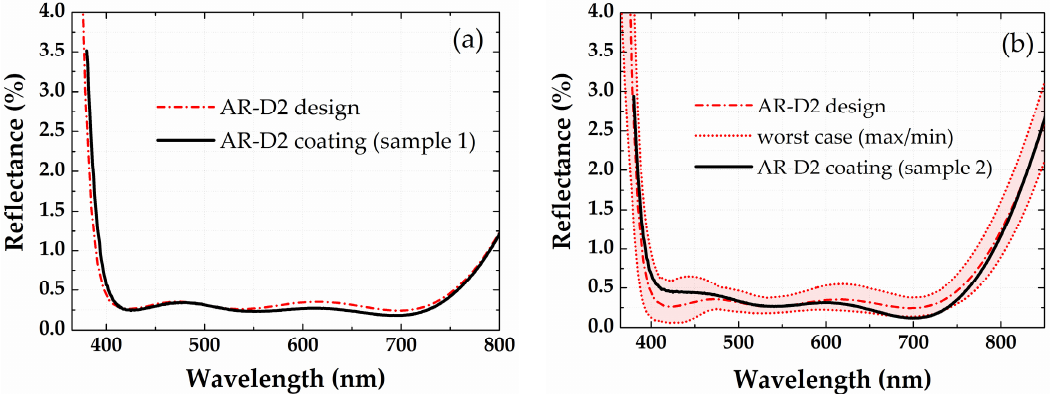
Figure 4. Measured and expected reflectance spectra of AR ‐ D2 on fused silica reference glass substrate positioned: ( a ) at the center of the substrate table; ( b ) at approximately 75 mm from the center table.